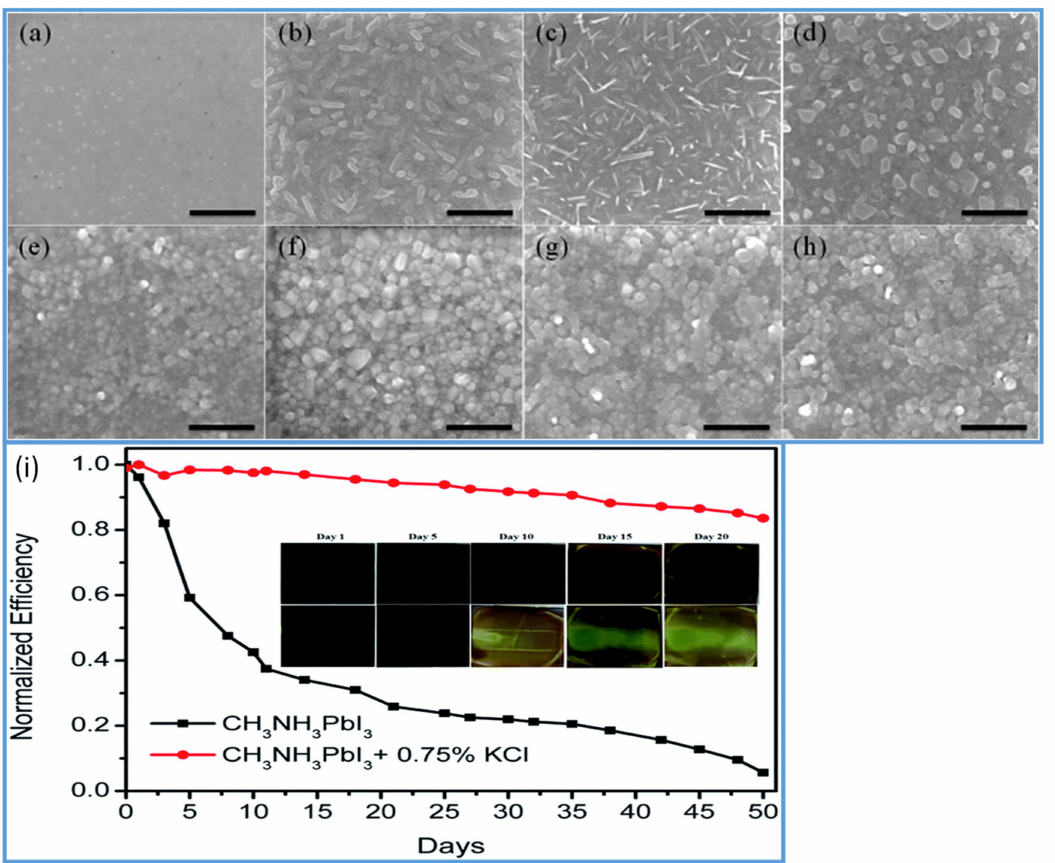
Figure 4. ( a – d ) SEM images of PbI 2 films and ( e – g ) SEM of images perovskite films. ( a and e ) prepared without additives. ( b , f ) with KCl, ( c , g ) with NaCl, and ( d , h ) with LiCl additives. ( i ) Normalized PCEs as a function of days, of PSCs fabricated with and without KCl as an additive. Inset: color changing images of the perovskite films in air with time. Reproduced with permission from ref. [101], Journal of Materials Chemistry A